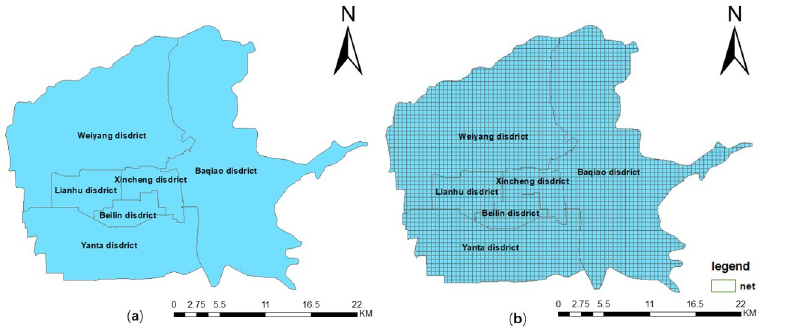
Fig 5. Study area. (a) Administrative divisions in the study area; (b) grid generation of the study area.